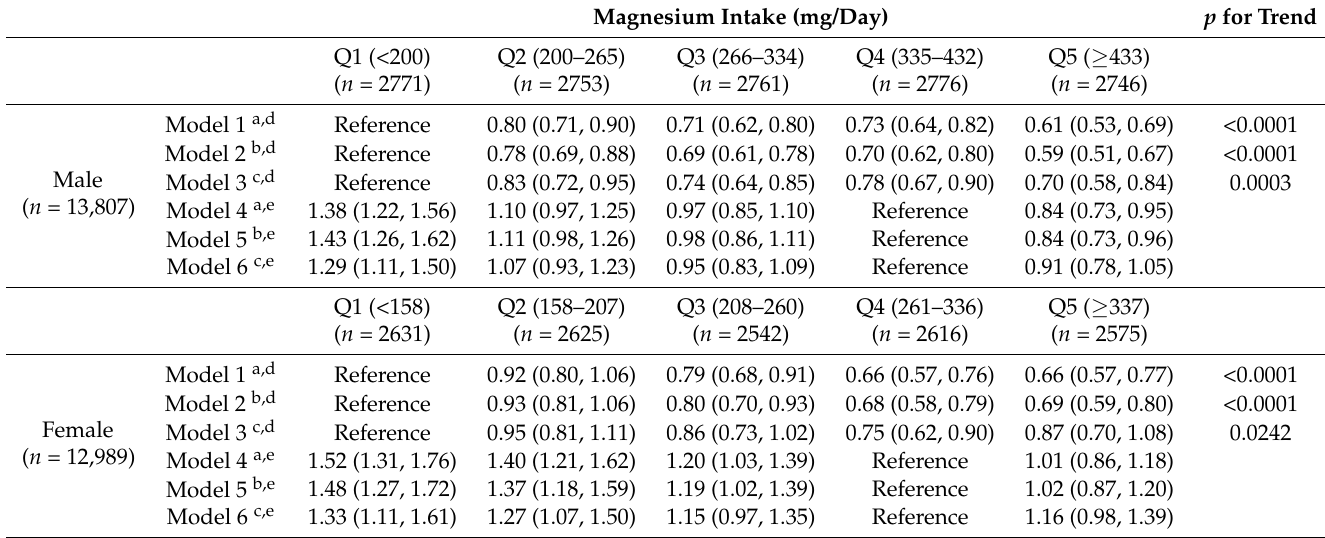
Table 4. Adjusted odds ratios of hyperuricemia among participants associated with magnesium